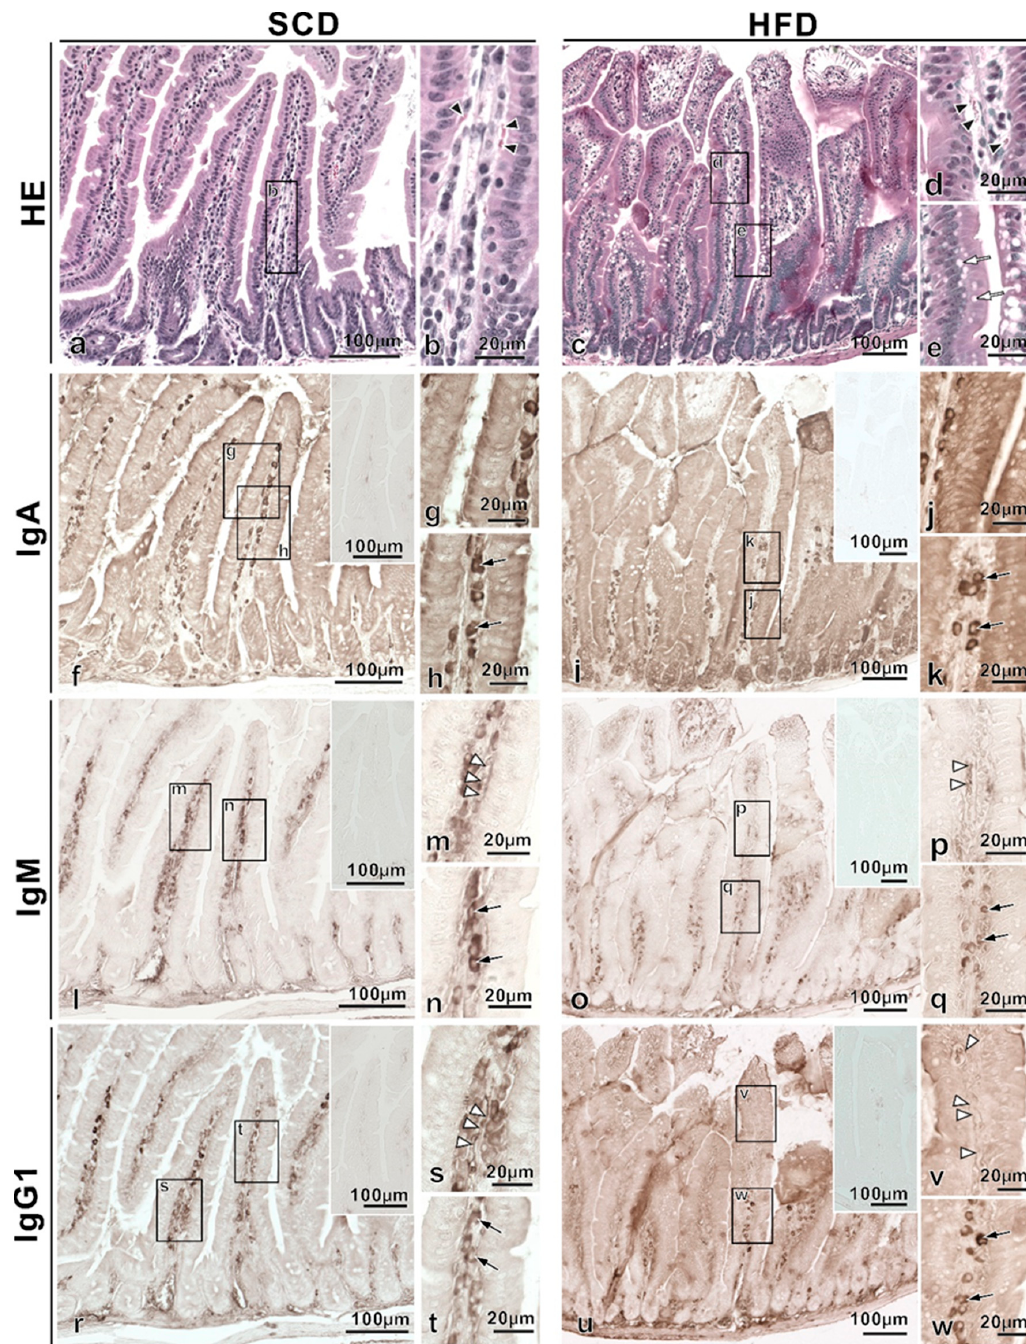
Figure 3. Comparison of the intestinal villi of standard chow diet (SCD) and high-fat-diet (HFD) fed 20-week-old mice. Paraffin-embedded tissue serial sections were obtained from each diet model. HE-staining of villi in the small intestines from standard chow diet (SCD)-fed mice showed regularly aligned simple columnar epithelium ( a , b ). HE-staining of tissue sections from high-fat-diet (HFD)-fed mice revealed vacuoles in monolayer columnar epithelial cells ( c , white arrows in e ). HE-staining of tissues from SCD and HFD-fed mice showed red blood cells (arrowheads in b , d ). IgA immunoreactivity in SCD-fed mice was detected in the cytoplasm of epithelial cells ( g ), and many IgA-immunopositive cells were also observed in the whole lamina propria of intestinal villi ( f , black arrows in h ). Meanwhile, 20-week-old HFD-fed mice exhibited IgA immunoreactivity localized on the bottom of the lamina propria ( i , j ), and IgA-immunopositive cells (black arrows in k ) were further reduced compared to those in SCD-fed mice. In both diet models, IgM and IgG1 immunoreactivity were observed in blood vessels (white arrowheads in m , s , p , v ) and Ig-immunopositive cells (arrows in n , q , t , w ). The inset also indicates immuno-controls ( f , i , l , o , r , u ).